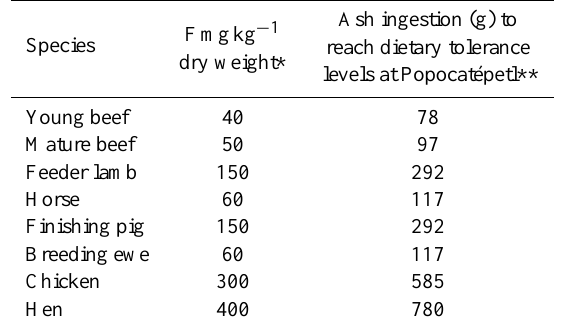
Fig. 4. pH values measured in leachates of the ash samples listed in Table